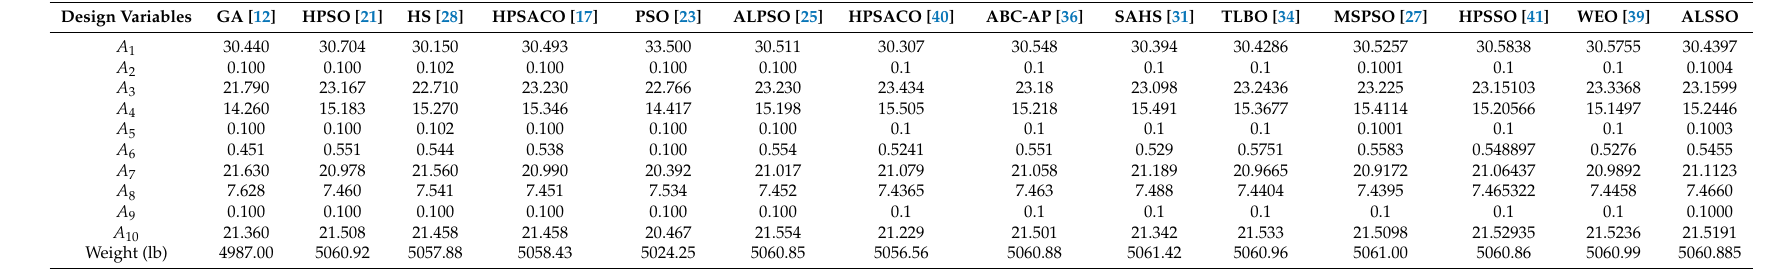
Table 1. Comparison of optimized designs for the 10-bar truss